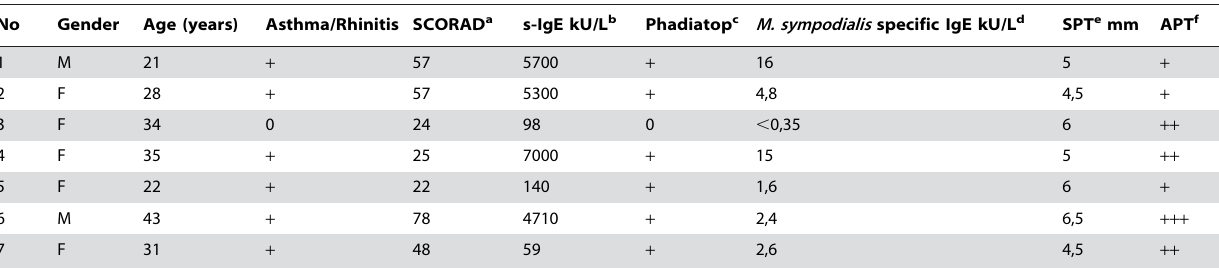
Table 2. Characterization of the AE